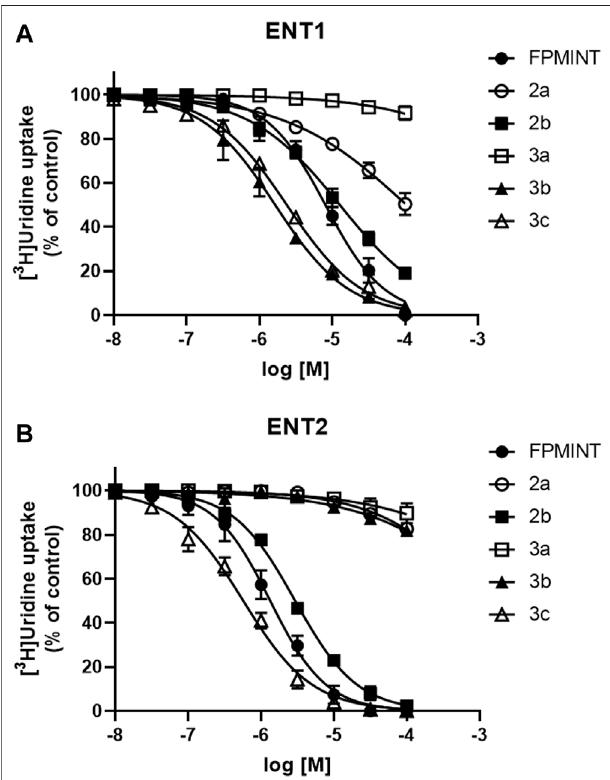
FIGURE 3 | Effects of FPMINT analogues (listed in Supplementary Table S2 ) on [ 3 H]uridine uptake by ENT1 and ENT2 [ 3 H]uridine uptake (1 μ M, 2 μ Ci/ml)in (A) PK15NTD/ENT1and (B) PK15NTD/ENT2cellswasmeasured in the presence of various concentrations of FPMINT analogues listed in Supplementary Table S2 (10 nM – 100 μ